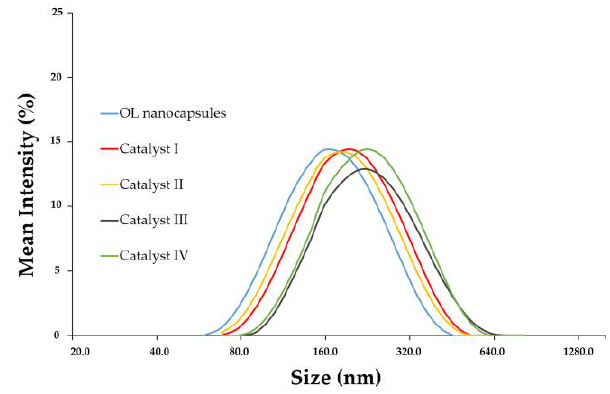
Figure 2. Representative particle diameter distributions of OL nanocapsules and Catalyst I – IV .